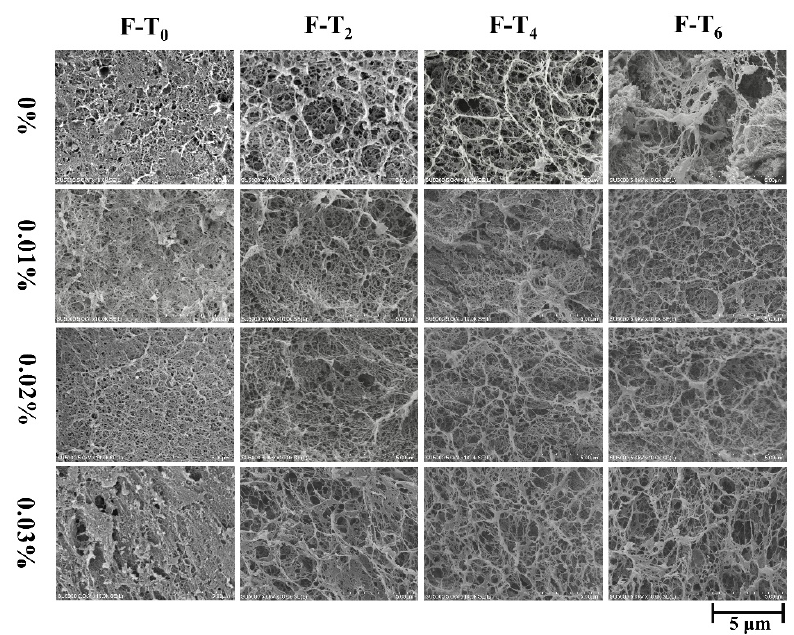
Figure 7. Changes in microstructure micrographs (magnification ×10,000) of surimi gels treated with different content EGCG during F-T cycles. 0%, 0.01%, 0.02%, and 0.03% represented 0%, 0.01%, 0.02%, and 0.03% EGCG content, respectively. Caption: see Figure 1.